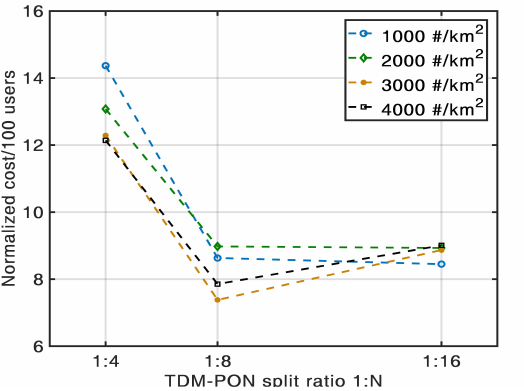
Figure 6. Variation of normalized cloudlet deployment cost/100 users against TDM-PON split-ratio 1 : N for a circular area with diameter = 4 km and D QoS = 1 ms.